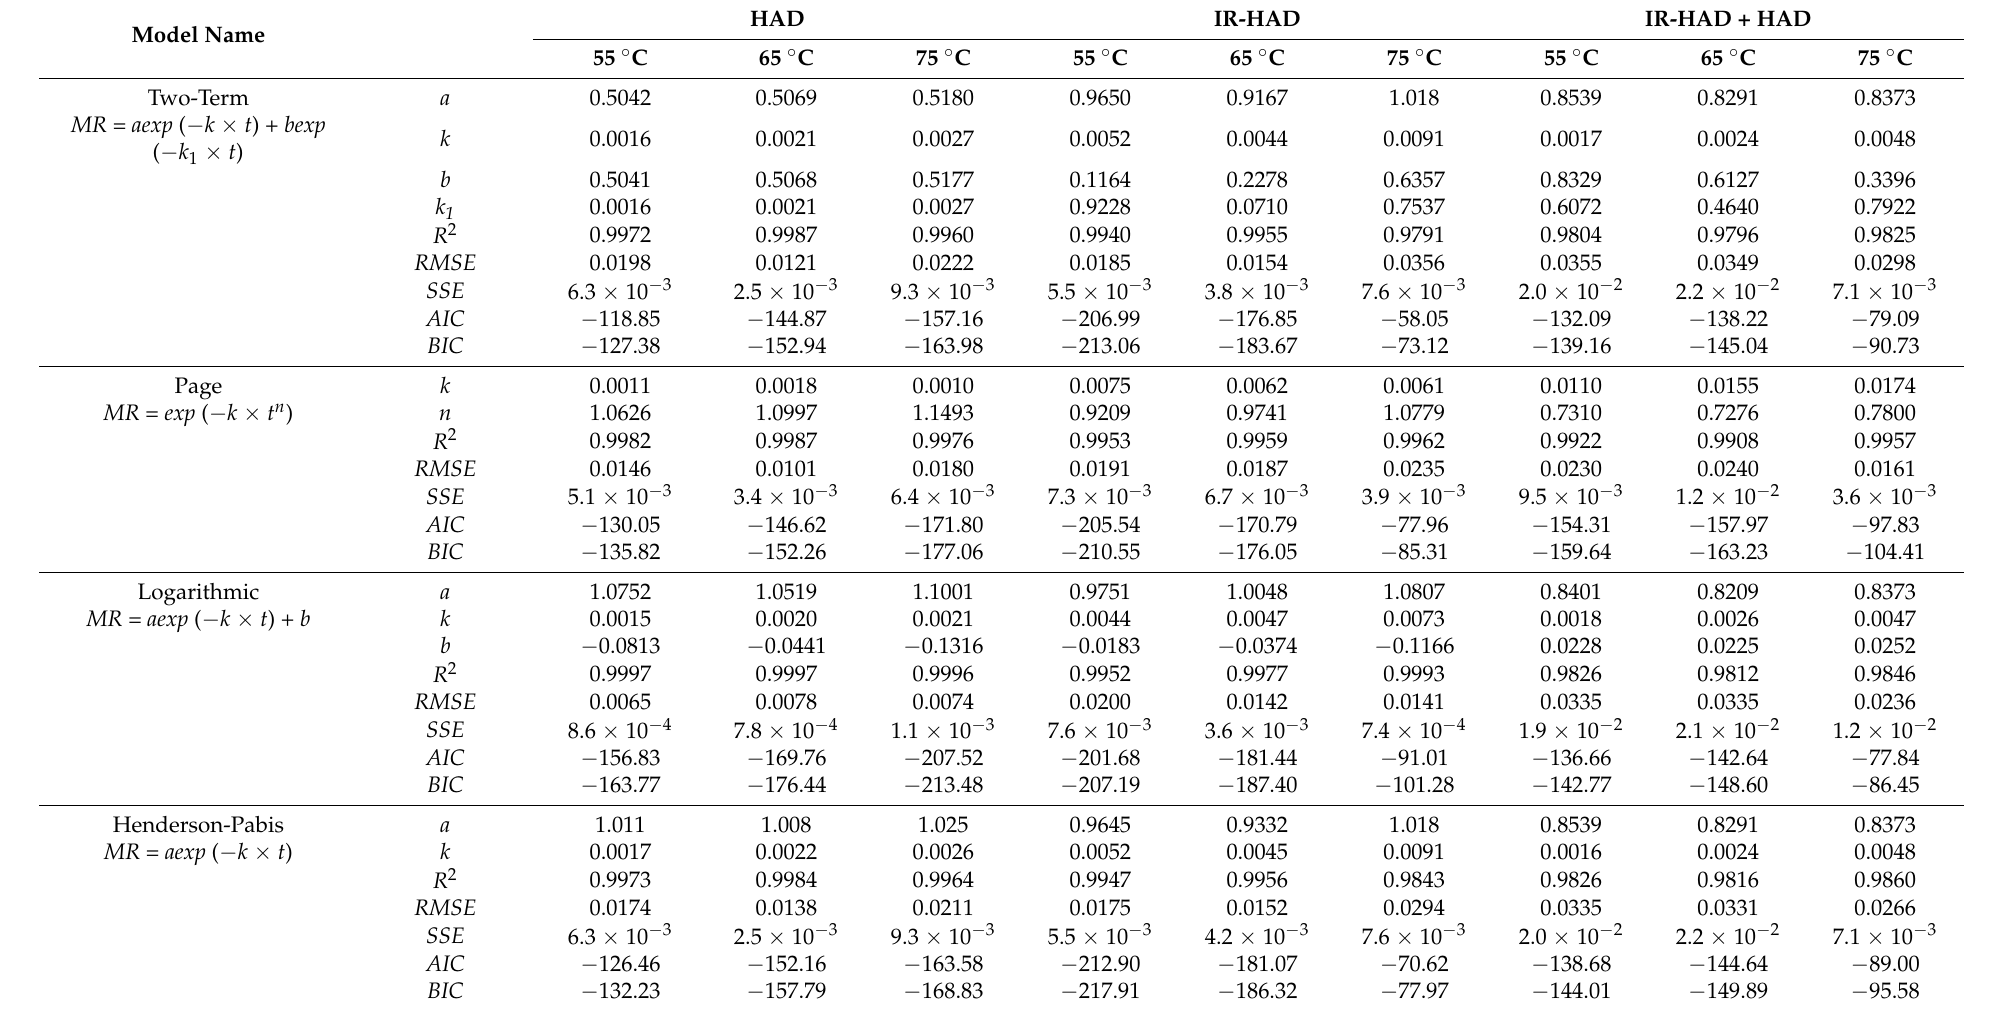
Table 1. Statistical results from different mathematical